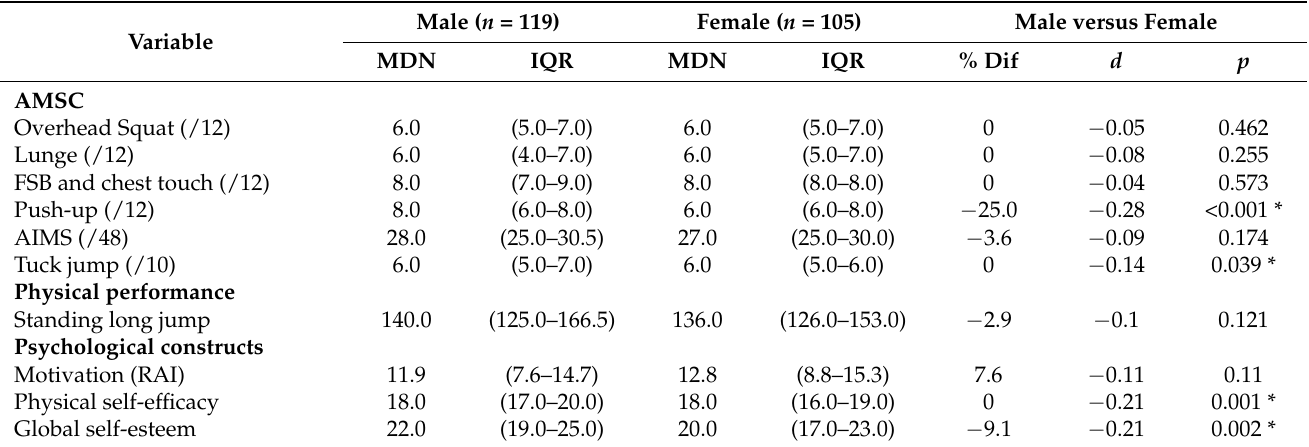
Table 4. Characteristics of AMSC, strength, and psychological attributes.